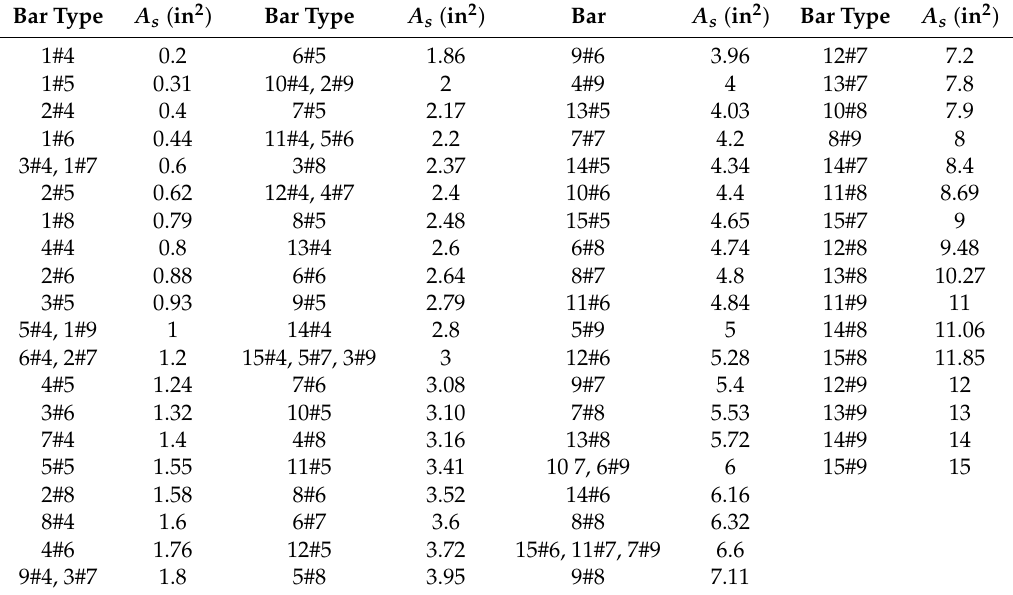
Table 2. Discrete values of the reinforcing